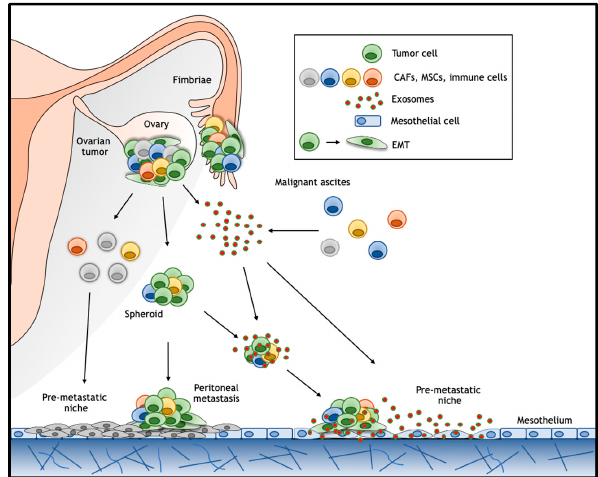
Figure 3. Model for peritoneal metastasis formation in ovarian cancer. Ovarian cancer follows a unique pattern of metastasis formation, where no anatomical barrier exists between the primary site